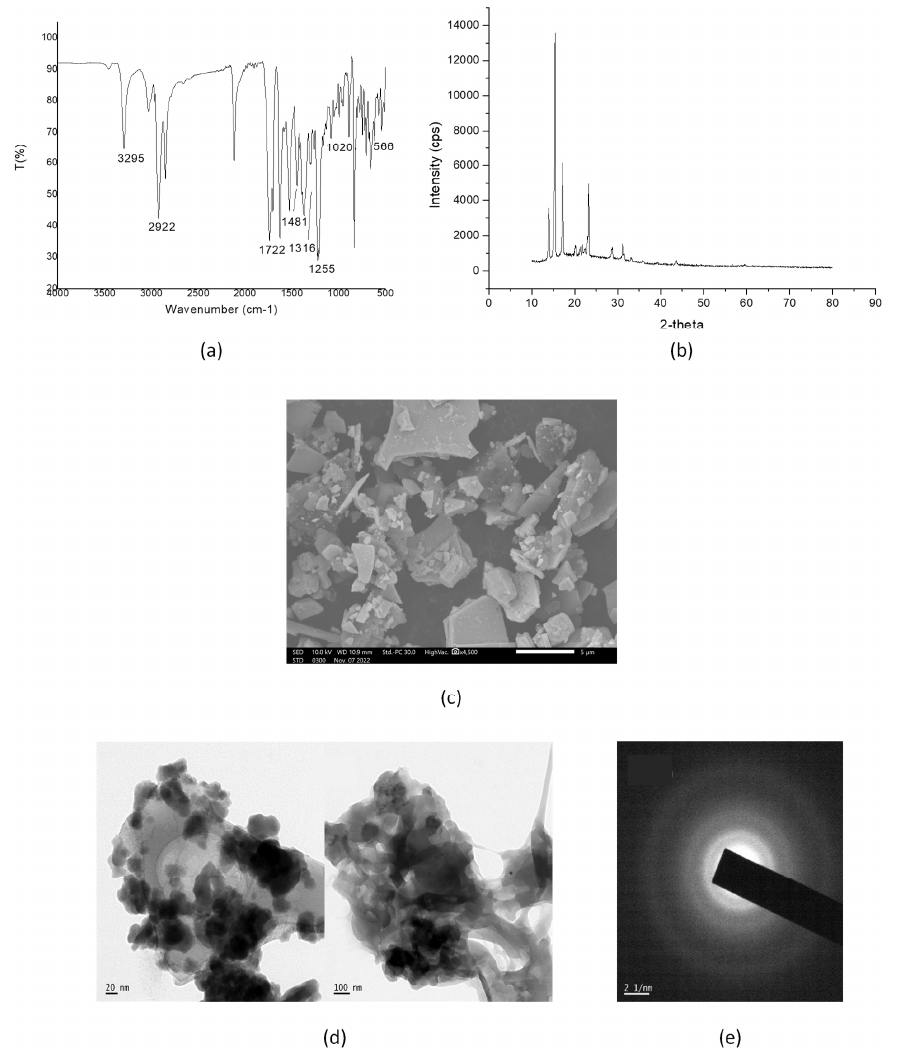
Figure 2. ( a ) FTIR spectrum of the surface ‐ modi fi ed Bi 2 O 3 nanoparticles using biotinylated β‐ cyclodextrin, ( b ) XRD pa tt ern of the surface ‐ modi fi ed Bi 2 O 3 nanoparticles using biotinylated β‐ cyclodextrin, ( c ) SEM image of the surface ‐ modi fi edBi 2 O 3 nanoparticles using biotinylated β‐ cyclodextrin, ( d ) TEM images of the surface ‐ modi fi ed Bi 2 O 3 nanoparticles using biotinylated β‐ cyclodextrin, and ( e ) SAED image of the surface ‐ modi fi ed Bi 2 O 3 nanoparticles using biotinylated β‐ cyclodextrin.